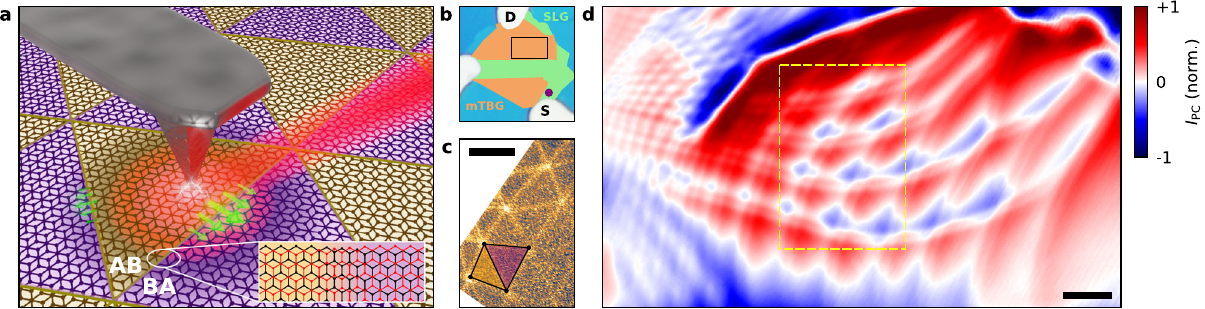
Fig. 1 Near- fi eld photoresponse in minimally twisted bilayer graphene. a Schematic illustration of near- fi eld photocurrent experiments performed in minimally twisted bilayer graphene. The moiré domains of different stacking con fi gurations are highlighted by yellow and purple shaded areas. The AFM tip couples infrared light into the device, causing the electron temperature to elevate locally. The photo-thermoelectric effect converts this heat partially into a current that can be read out by the contacts. Inset: Zoom of the domain wall structure separating AB-BA domains of the more lattice. b Device schematic of the main device under study. It consists of different regions of single-layer graphene (SLG) and minimally twisted bilayer graphene (mTBG) due to folding/ stacking faults during the heterostructure assembly. The geometry for photocurrent measurements in d is marked by S (source) and D (drain). The third contact is left fl oating. The purple dot marks the position where the calibration of carrier density is done (Supplementary Note 1). c Near- fi eld scattering phase image corresponding to the yellow dashed rectangle in d , measured at E = 117 meV and n ~ 5 × 10 12 cm − 2 . The two shaded triangles mark two domains. Length of scale bar: 500 nm. d Photocurrent map of mTBG corresponding to the black rectangle in b , measured at carrier density n ~ 1 × 10 12 cm − 2 with an excitation energy E = 188 meV. Length of scale bar: 500 nm. The map is normalised by the maximum measured I PC